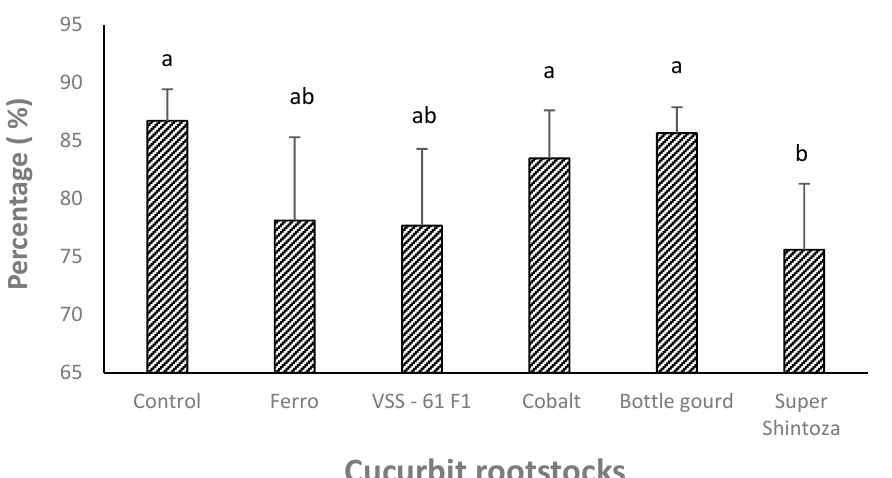
Figure 2. Percentage of leaf electrolyte leakage (mean ± SD) of Gianco F1 cucumber plants grafted onto five cucurbit rootstocks and the ungrafted control under soil salinity and heat stresses in the 2018 season. Different letters indicate significant differences between treatments according to Duncan’s test at p < 0.05. Details on the measurement of the trait presented are provided in the Material and Methods Section.